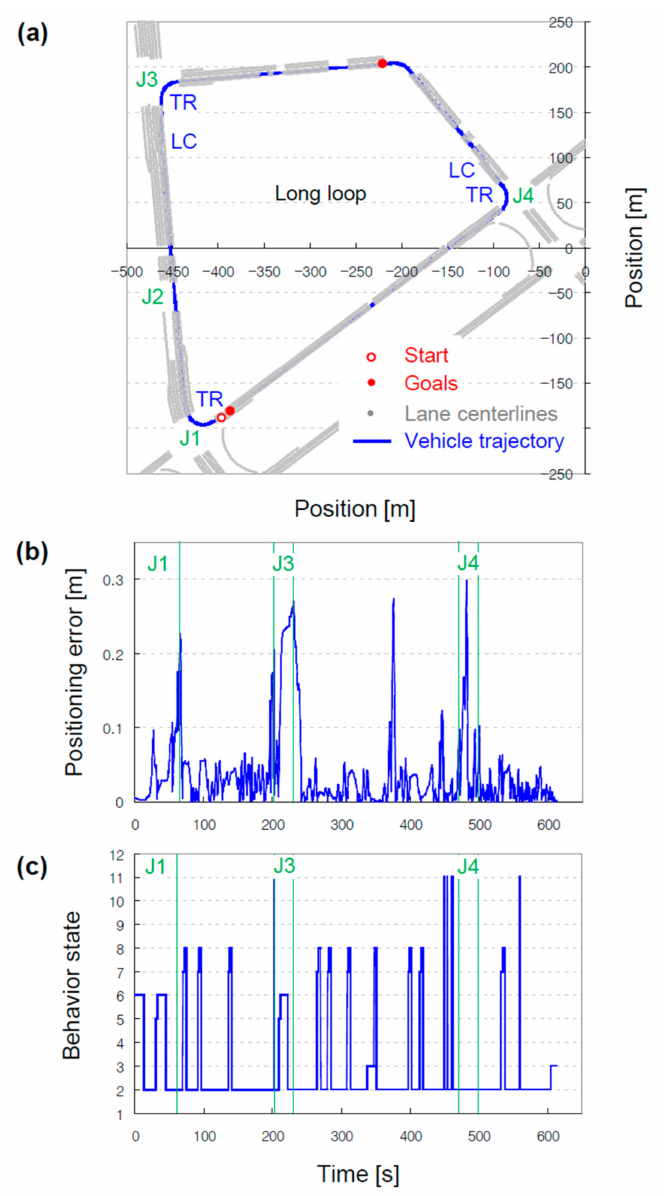
Figure 11. Validation results of the generated road network map. ( a ) Vehicle trajectory from the start to goal locations, generated based on lane centerlines. J, LC, and TR refer to junction, lane changing, and right turn, respectively. ( b ) Positioning error, a measurement by comparing the current positions of the vehicle and its nearest waypoint. ( c ) Behavior state transition according to operations supported by the generated vector